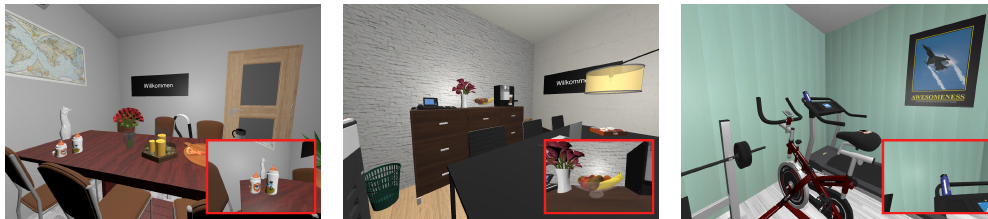
Figure 1. Views from three virtual rooms. Examples of target items (from left to right: baby bottles, fruit bowl, drinking bottle) appear within red frames. The black display screen appears in the first two rooms as an illustration of its position only (it is not actually visible in